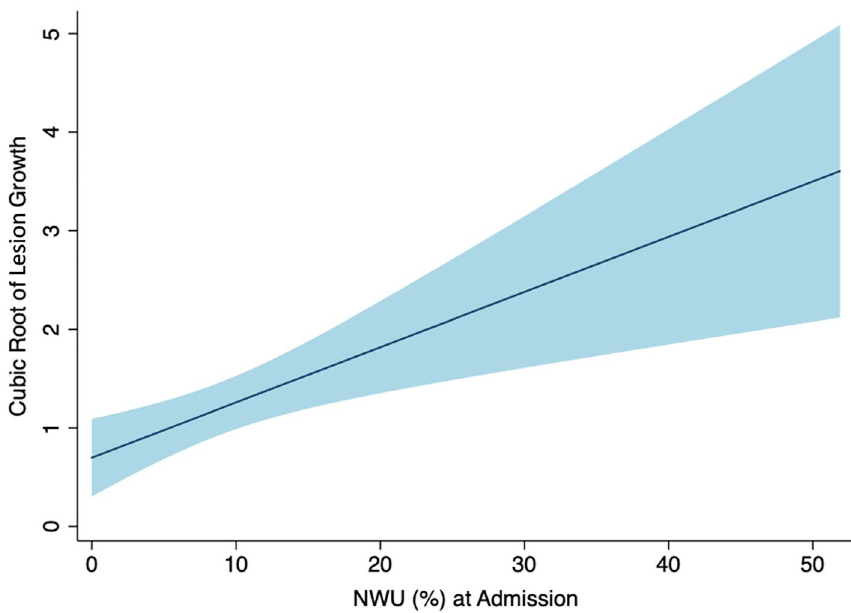
Figure 4. Relationship between NWU and lesion growth. Lower NWU was significantly associated with less lesion growth. NWU net water